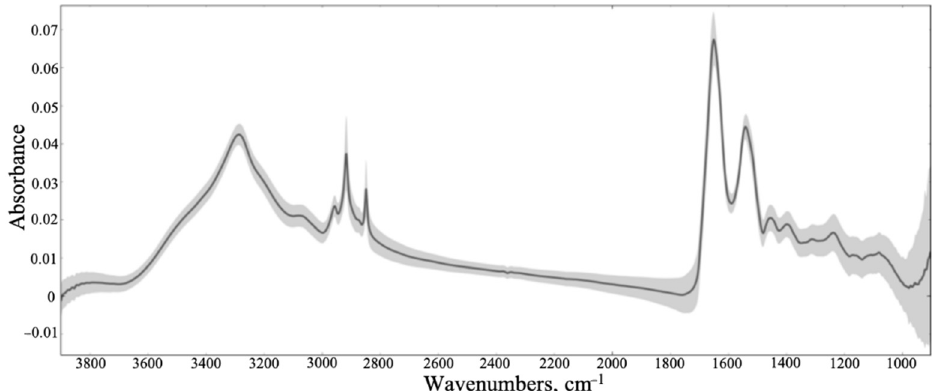
Figure 5. Mean spectra of all samples combined after extended multiplicative signal correction (EMSC), principal component analysis (PCA) quality test and removal of Amide I outliers with the standard deviation shaded in grey.